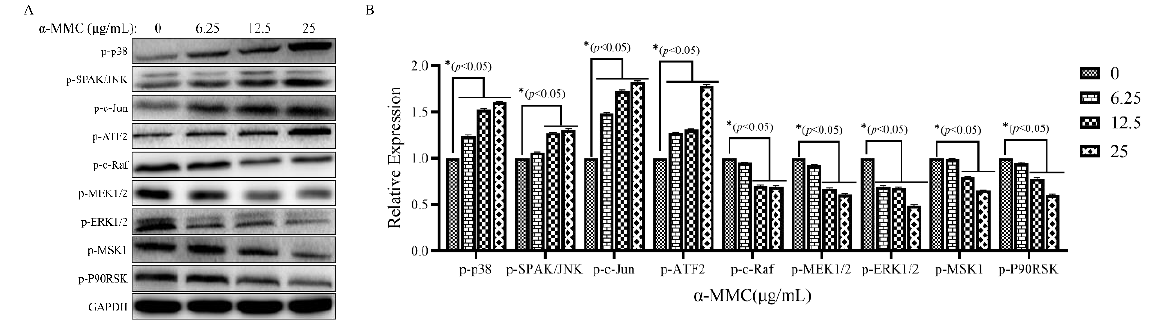
Figure 5. Effect of α -MMC on the MAPK cascade signaling in MM.1S cells. The expression levels of MAPK-signaling-pathway-related proteins in MM.1S cells were detected using Western blot ( A ); GraphPad Prism 9.0 software was used to draw a histogram to reflect the relative expression levels of proteins ( B ). In the experimental group (6.25, 12.5, 25 μg/mL α -MMC group) comparisons with the control group (0 μg/mL α -MMC group), * p < 0.05 was considered to be statistically significant.